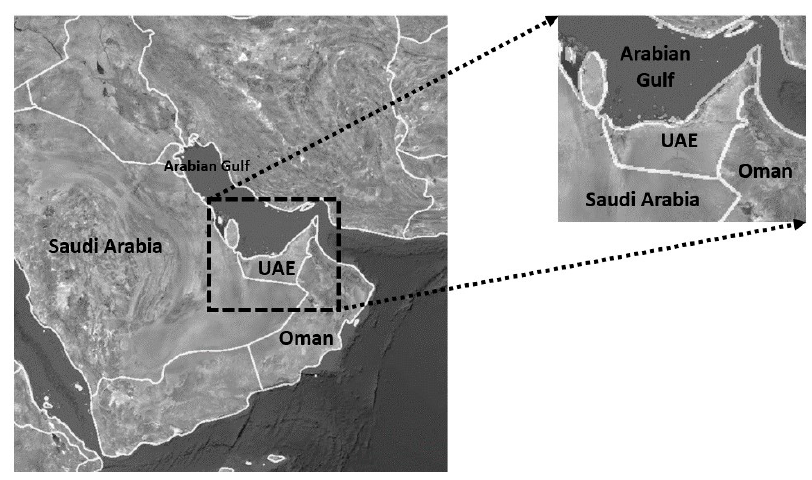
Figure 1. Location of the study region (United Arab Emirates).